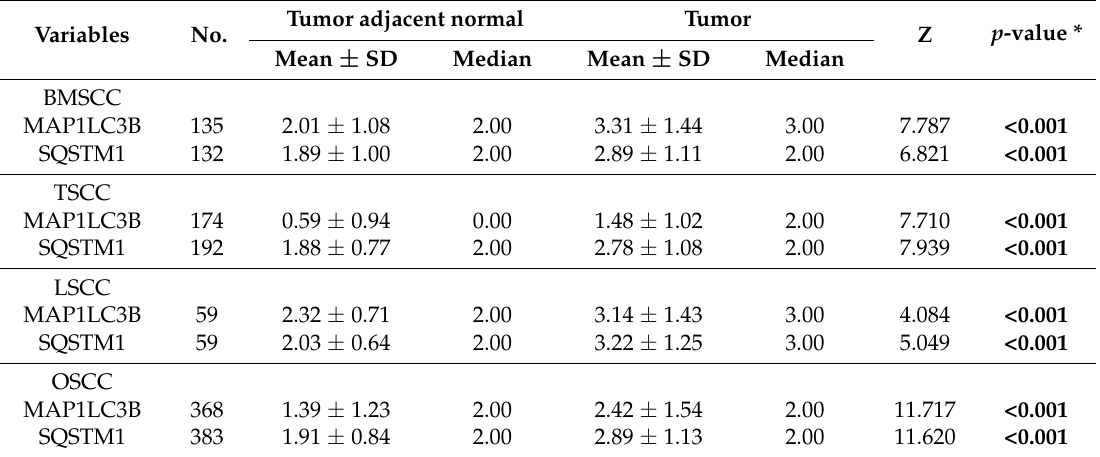
Table 1. Comparisons of MAP1LC3B and SQSTM1 expression between tumor tissues and corresponding tumor adjacent normal tissues at three subsites of oral